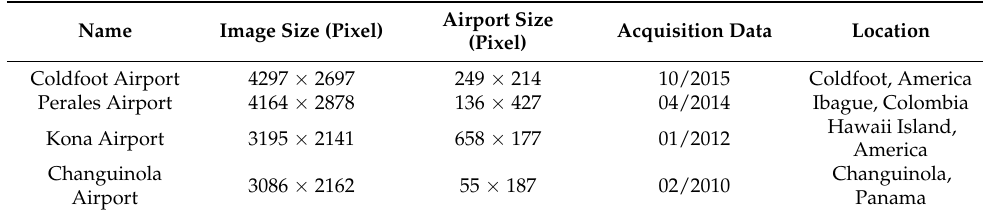
Table 4. Description of the data for airport